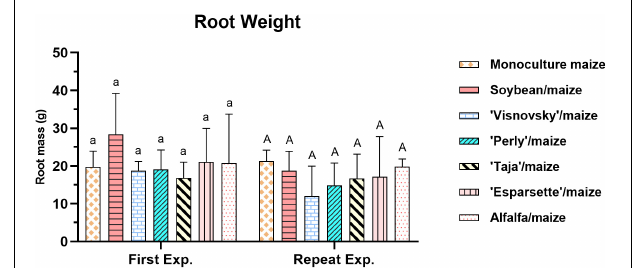
incorporation of aerial material of maize (P-2432-R), soybean (DM-5953-RSF), sainfoin (Esparsette, Taja, Perly, Visnovsky), and alfalfa (BAR 7) into the soil and rotation thereof. The y -axis shows plant weight (g). Different letters indicate significant differences at P ≤ 0.05 based on Tukey’s test for each experiment